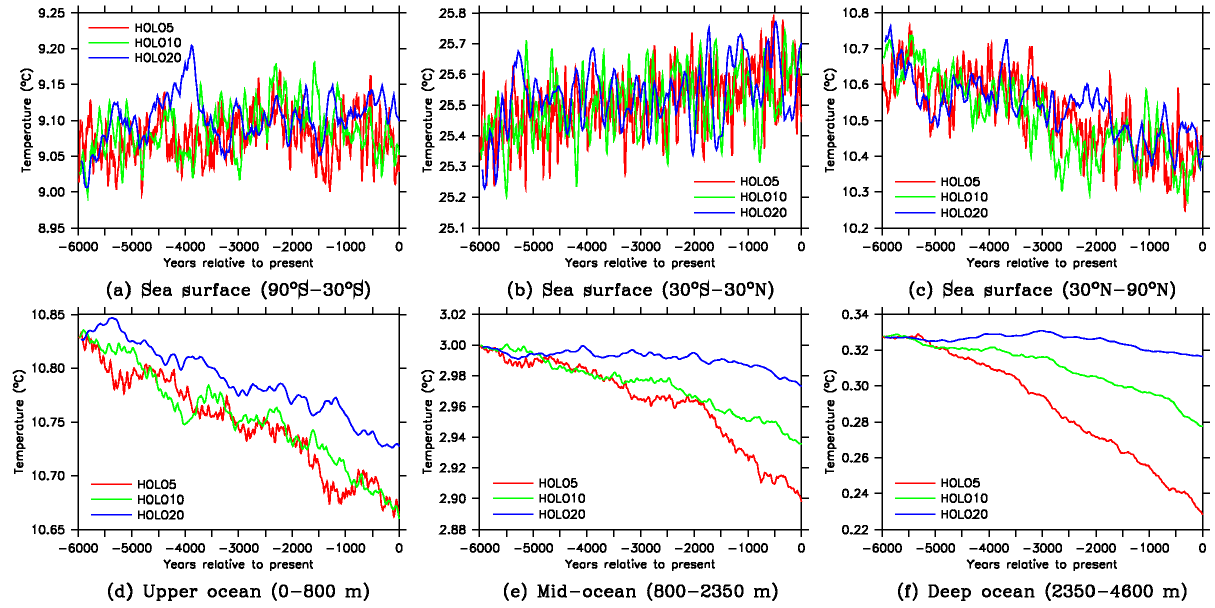
Fig. 11. The evolution of annual-mean potential temperature during experiments HOLO5 (red), HOLO10 (green) and HOLO20 (blue): (a) the sea surface (90–30 ◦ S), (b) the sea surface (30 ◦ S–30 ◦ N), (c) the sea surface (30–90 ◦ N), (d) the upper ocean (0–800m), (e) the mid-ocean (800–2350m), and (f) the deep ocean (2350–4600m). The values shown are running means across five model